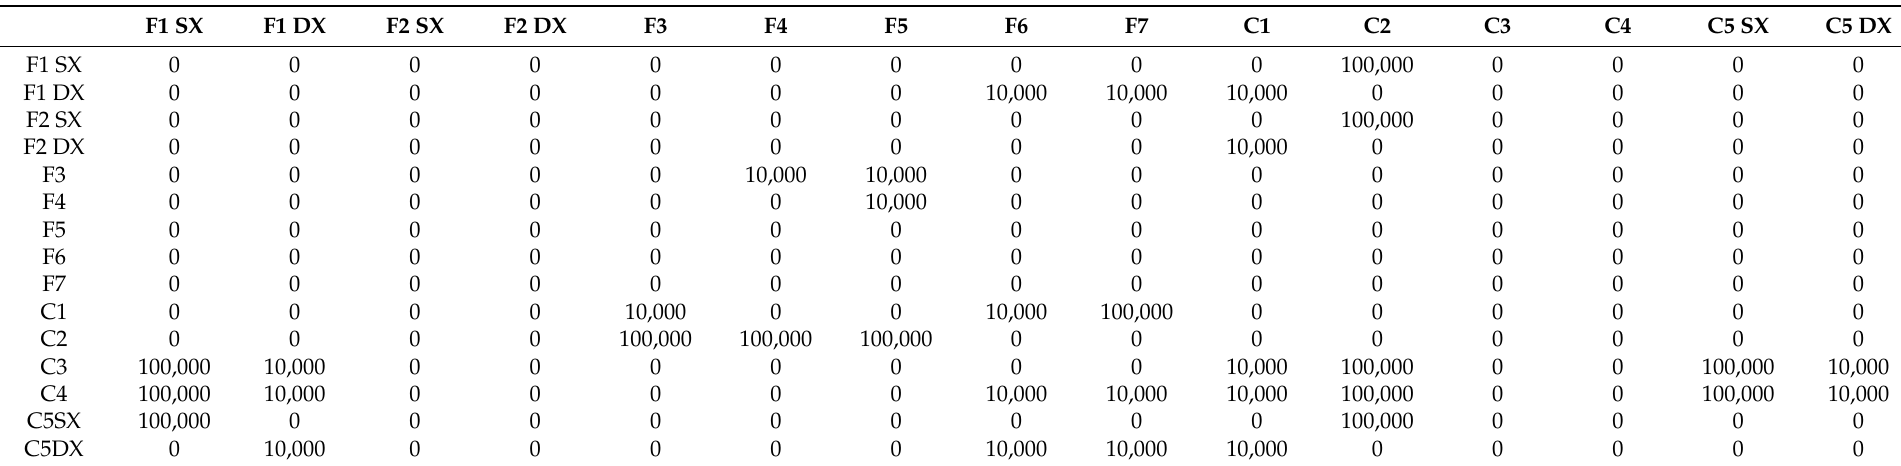
Table 2. Disassembly precedence